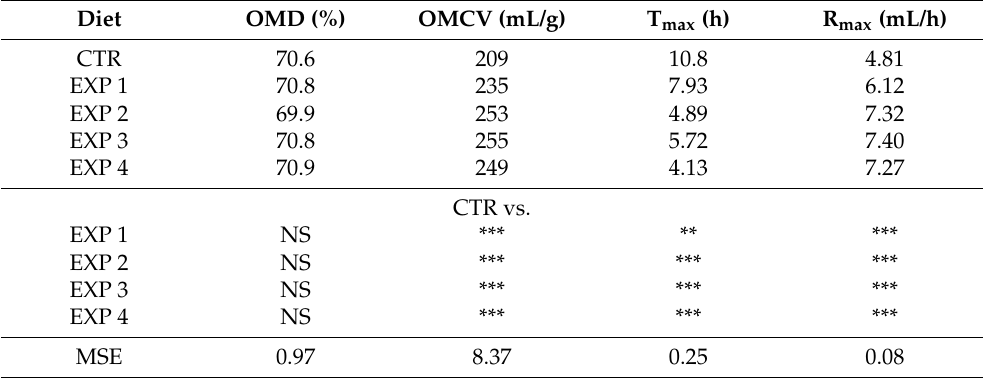
Table 4. In vitro fermentation parameters: control vs. experimental diets with buffalo inoculum .